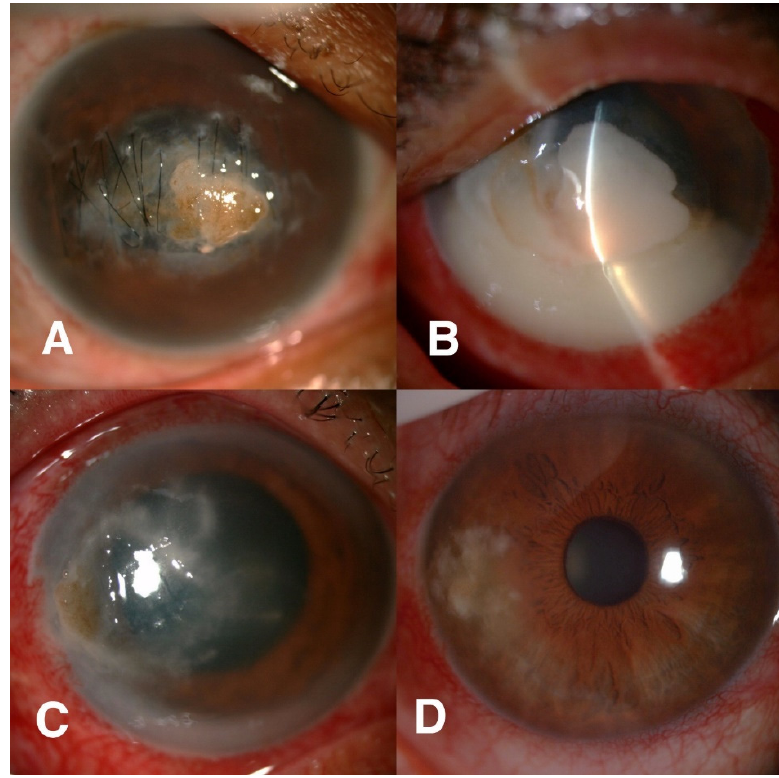
Figure 2. Clinical photograph of dematiaceous keratitis cases. ( A ) Clinical photograph showing dif- fuse brown pigmentation in the anterior stroma; ( B ) clinical photograph under silt-beam illumination showing a pigmented raised/elevated lesion; ( C ) clinical photograph showing a ring infiltrate and feathery borders; ( D ) clinical photograph showing a dendritic lesion in the inferotemporal quadrant of